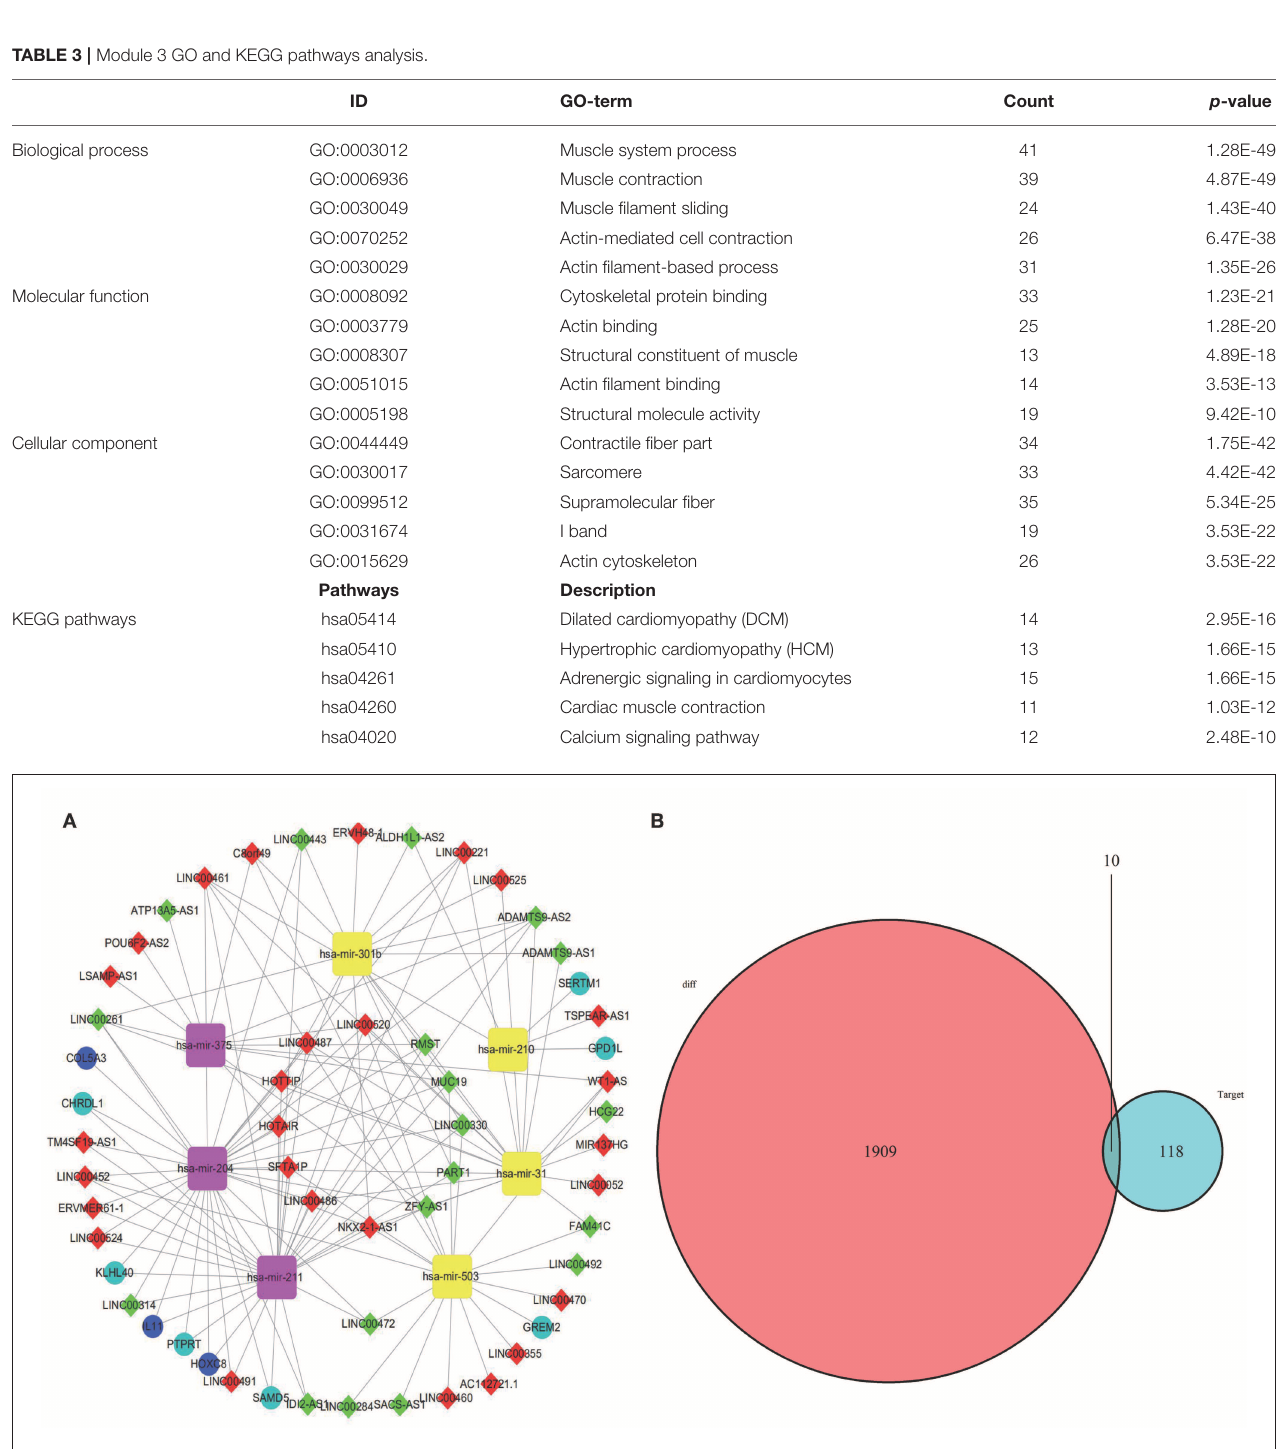
FIGURE 4 | CeRNA network was visualized in Cytoscape (A) . The yellow represents miRNA upregulation and purple downregulation. The red means lncRNA upregulation and green downregulation. The mazarine indicates mRNA upregulation and blue downregulation. Gray edges indicate